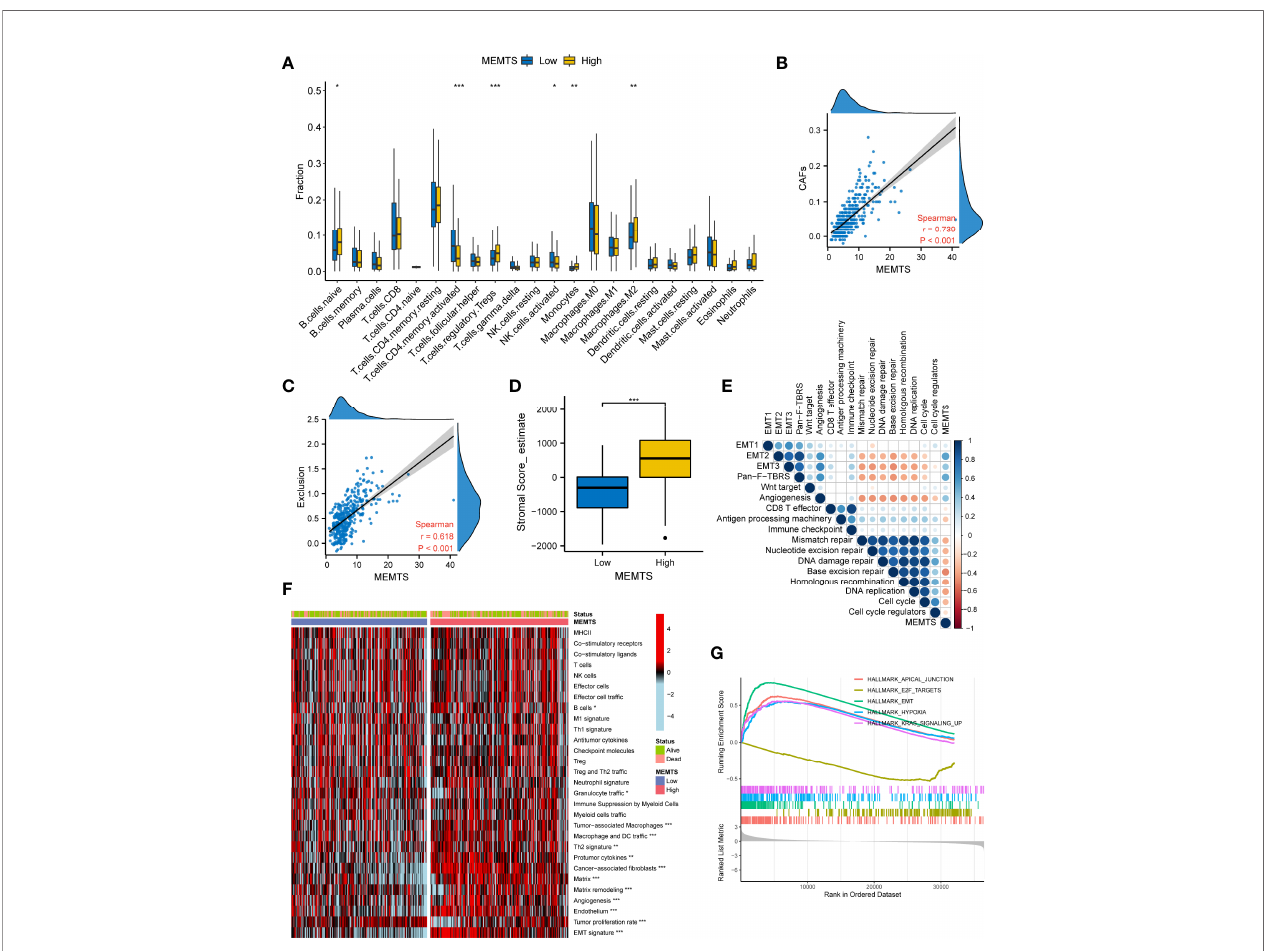
FIGURE 6 | Correlation between the MEMTS and tumor microenvironment in gastric cancer (TCGA cohort). (A) Box plots illustrating the relationships between MEMTS subtypes and the in fi ltration of 22 immune cells (*P < 0.05; **P < 0.01; ***P < 0.001, Wilcoxon test). (B) Spearman analysis of correlation between MEMTS and CAFs (Spearman test, r=0.739, P < 0.001). (C) Scatter plot depicting a close correlation between MEMTS and T cell exclusion (Spearman test, r=0.618, P < 0.001). (D) stromal score calculated by estimate were signi fi cantly associated with MEMTS subtypes (Wilcoxon test, ***P < 0.001). (E) A corrplot demonstrating correlations among MEMTS and the known gene signatures in TCGA cohort by Spearman analysis. Coef fi cients are characterized in color and size. Negative and positive correlations are marked with orange and blue, respectively. (F) heatmap displaying the relationship among the MEMTS, the status and the pathways related to immunity and tumorigenesis in two subtypes (*P < 0.05; **P < 0.01; ***P < 0.001, Wilcoxon test). (G) Curves showing the results of gene enrichment in apical junction, E2F targets, EMT, hypoxia pathways and KRAS